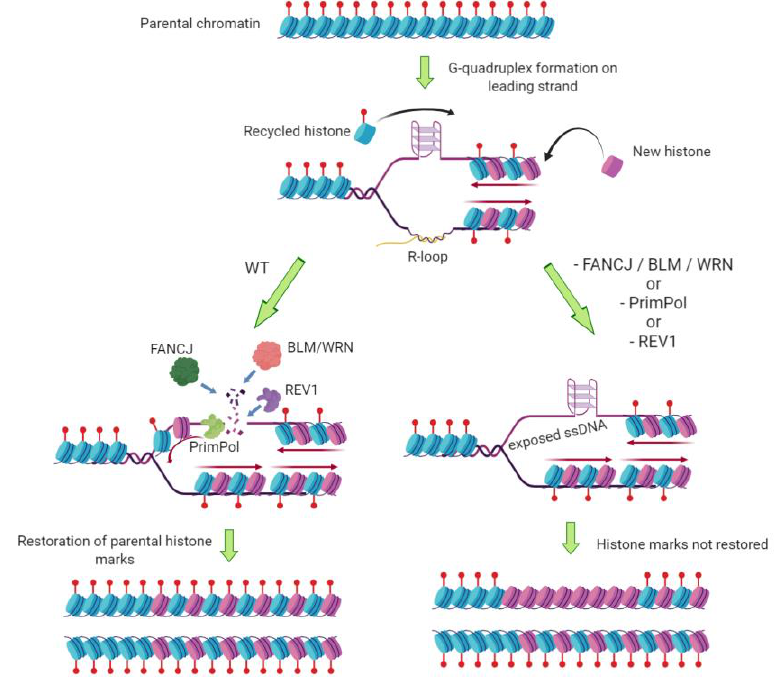
Figure 2. Model for the mechanism of G4-mediated changes to histone modifications and gene expression (adapted from [19,79]). G-quadruplex formation at the replication fork can block replication (here depicted with the G4 on the leading strand, but it may also block lagging strand synthesis). ( Left panel ): FANCJ, BLM or WRN helicases can remove the G-quadruplex, and DNA synthesis past the impediment can be promoted by REV1 or PrimPol. ( Right panel ): in the absence of any of these pathways, an extended region of single-stranded DNA template may accumulate. The subsequent DNA synthesis needed to fill this gap would be uncoupled from the incorporation of parental histones into the newly replicated DNA strand, resulting in a loss of the restoration of parental histone marks. Figure created with BioRender.com.